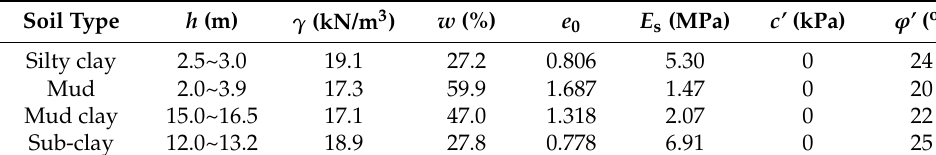
Figure 10. Schematic diagram of piled embankment profile. Table 2. Physical and mechanical indexes of the soil layer.